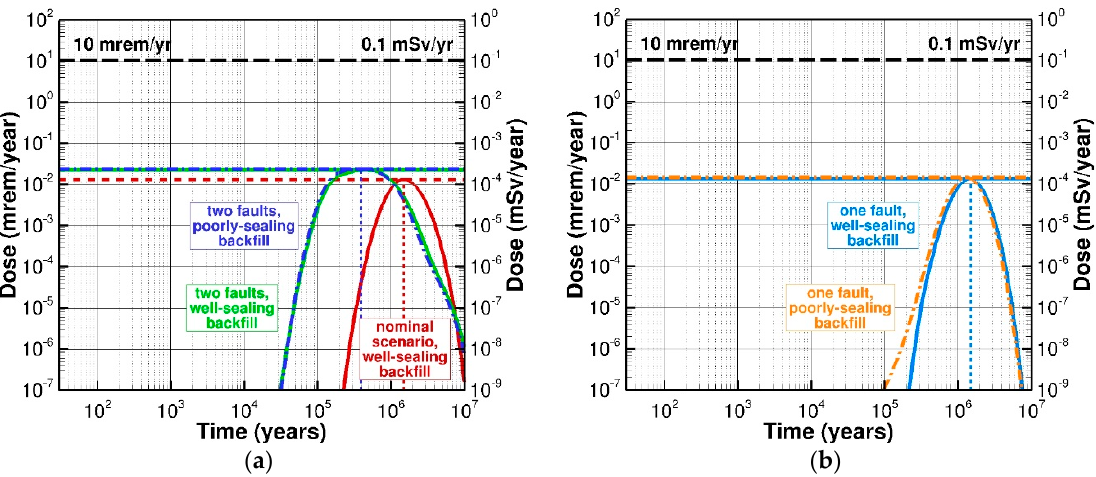
Figure 12. Annual exposure dose with well ‐ sealing and poorly ‐ sealing backfill for ( a ) reference and two ‐ fault scenarios, and ( b ) one fault scenario.